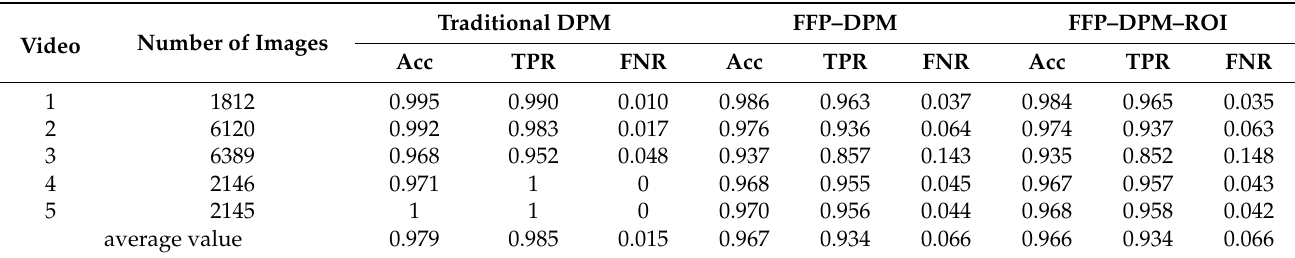
Table 2. Comparison of detection accuracies of different algorithms for each